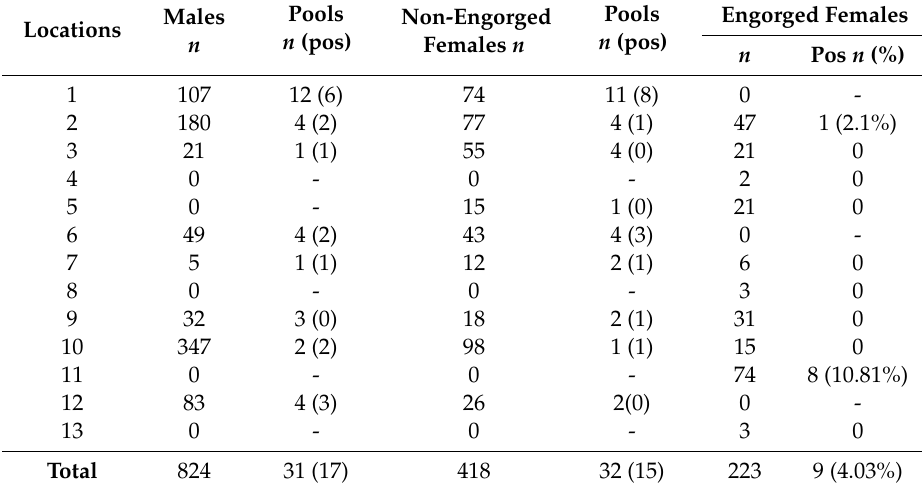
Table 1. Distribution of the Wutai mosquito phasivirus positive (pos) Culex spp. pools according to the trapping